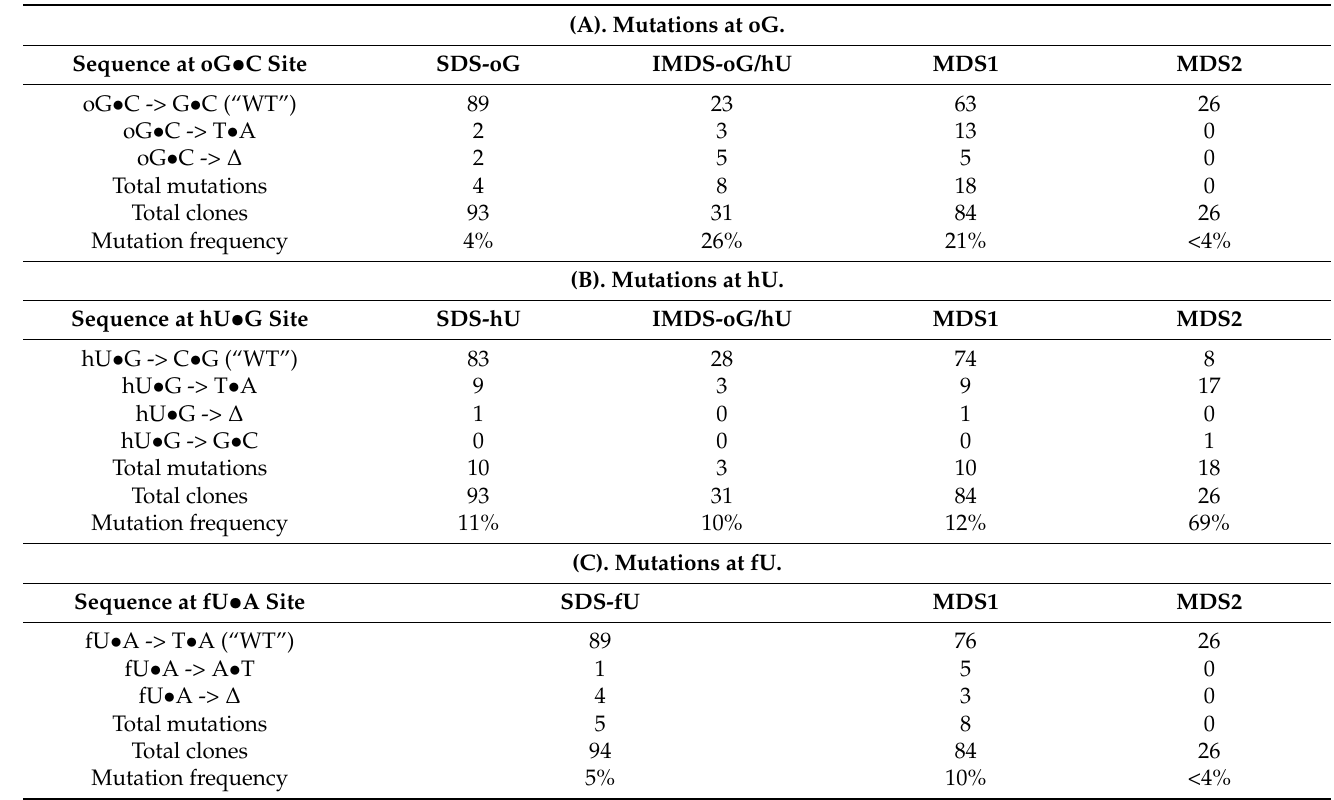
Table 1. Mutation type and frequency at oG, hU, and fU in SDS or complex MDS in WT strain. (A). Mutations at